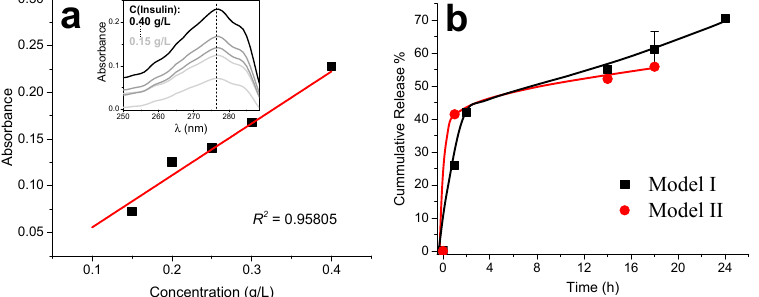
Figure 12. ( a ) Insulin standard calibration curve obtained by UV spectrophotometry for the absorbance measured at 276 nm wavelength. Inset shows the UV spectra obtained for the different insulin standard concentrations. ( b ) Cumulative insulin release from chitosan-caseinate nanoparticles obtained following the Model I and II approaches of Scheme I, as determined by UV spectrometry at 276 nm wavelength .